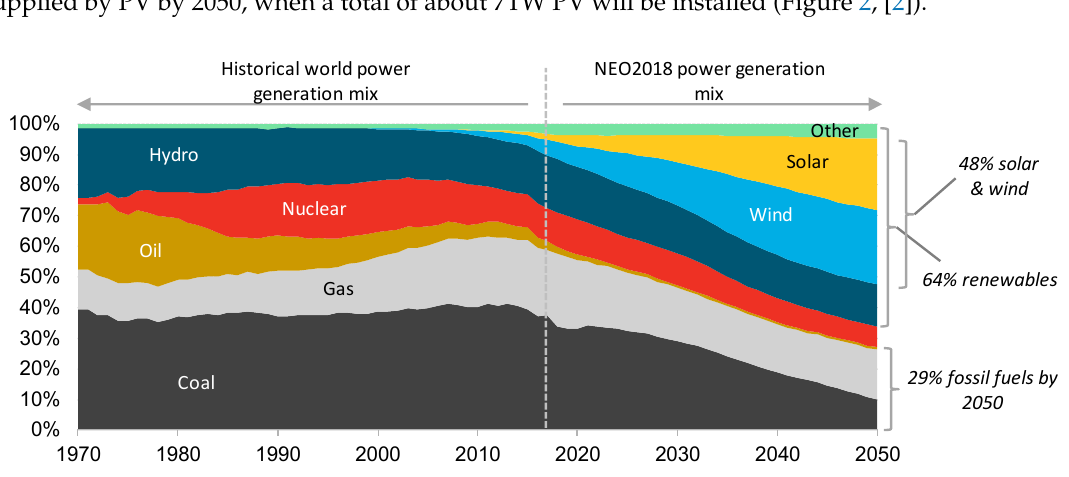
Figure 2. Global electricity generation mix. Note: NEO is short for new energy outlook, which is an annual publication by BloombergNEF.